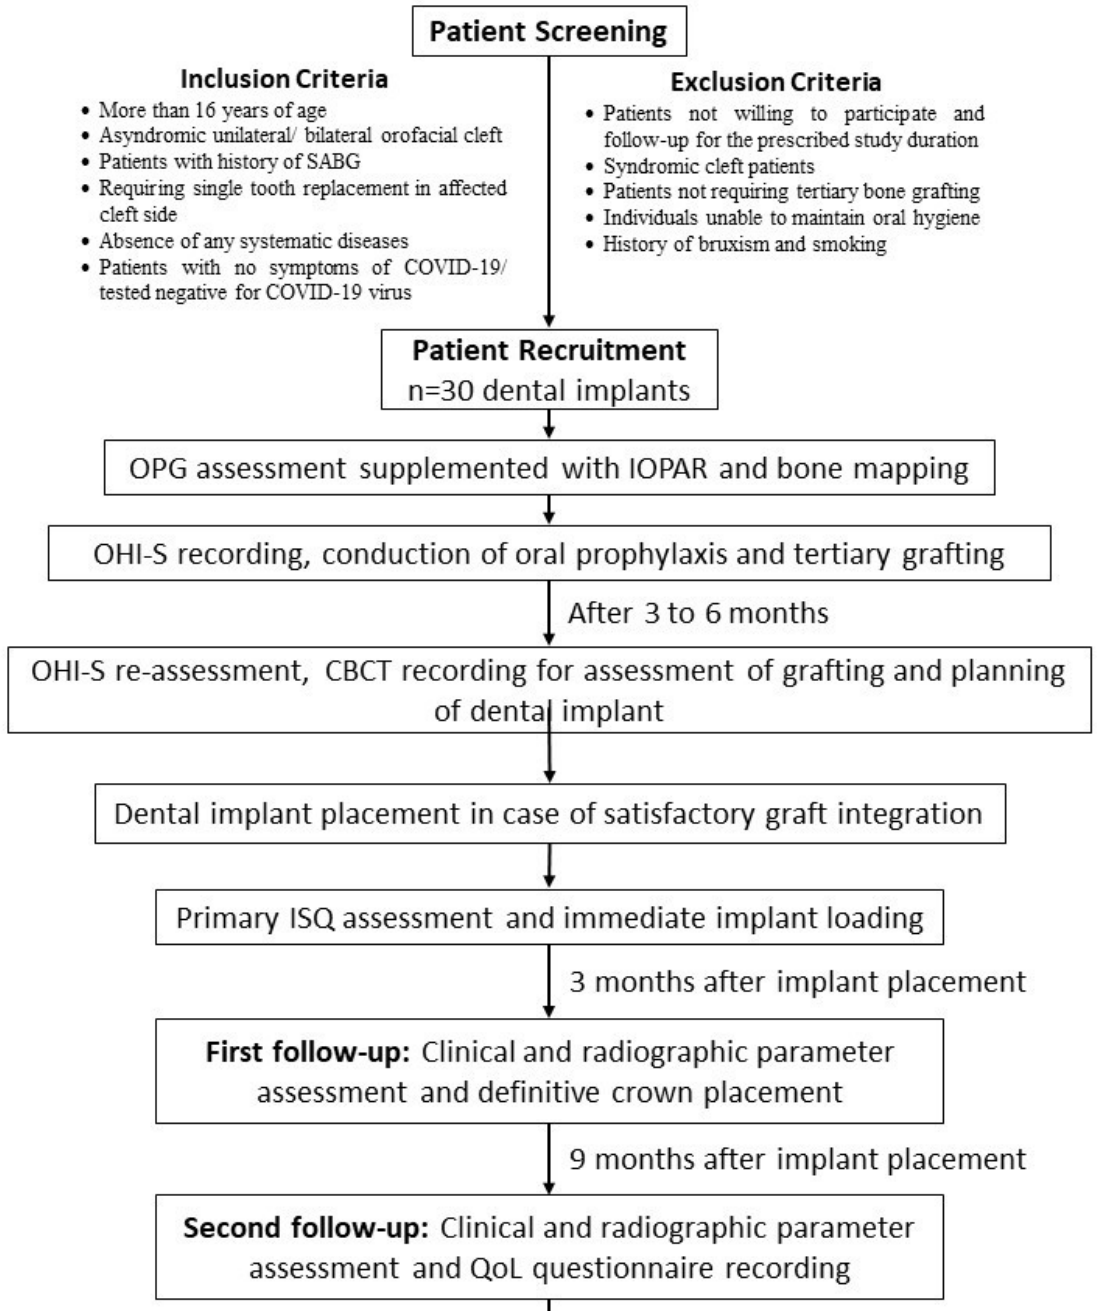
Figure 1. Summary of the research methodology. CBCT: cone beam computed tomography; IOPAR: intraoral periapical radiograph; ISQ: